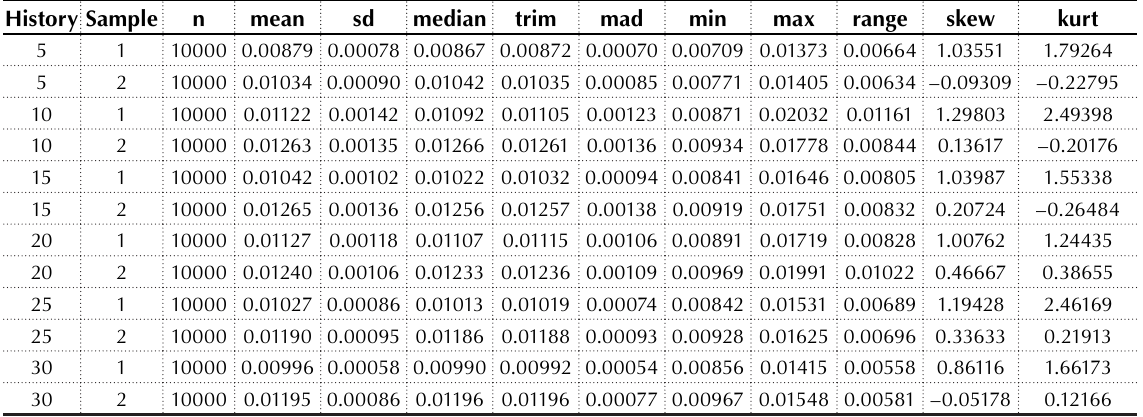
Table 3. Descriptive statistics of minimized standard deviation of the portfolio History